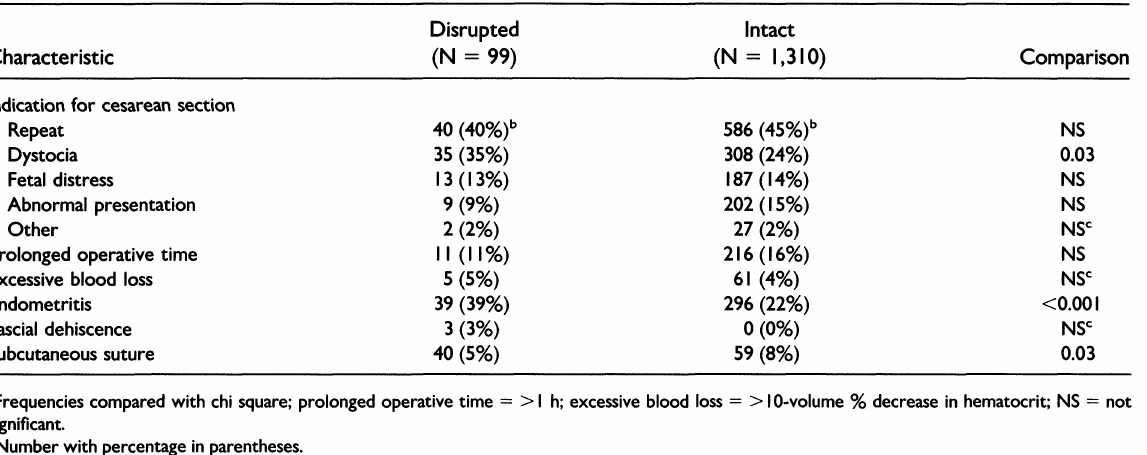
TABLE 4. Intraoperative and puerperal characteristics in 99 women with wound disruption compared with 1,310 women without this complication a